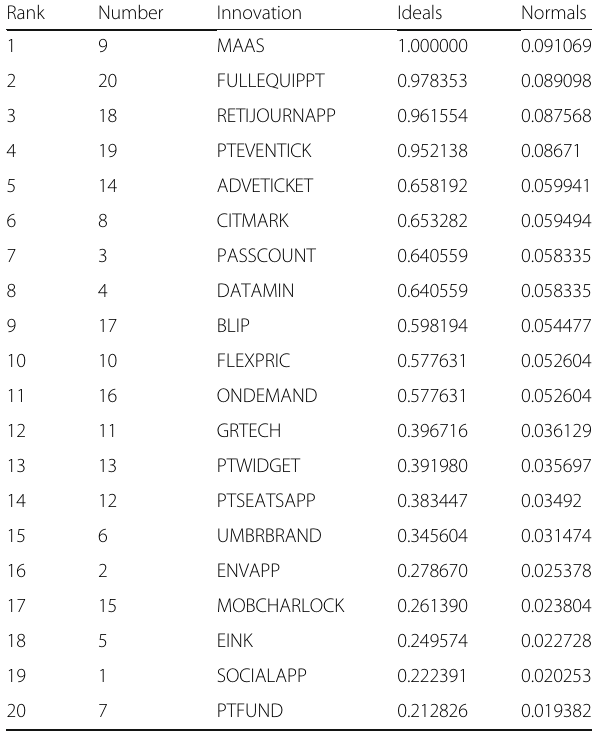
Table 6 Ranking of innovations with respect to Utility Rank